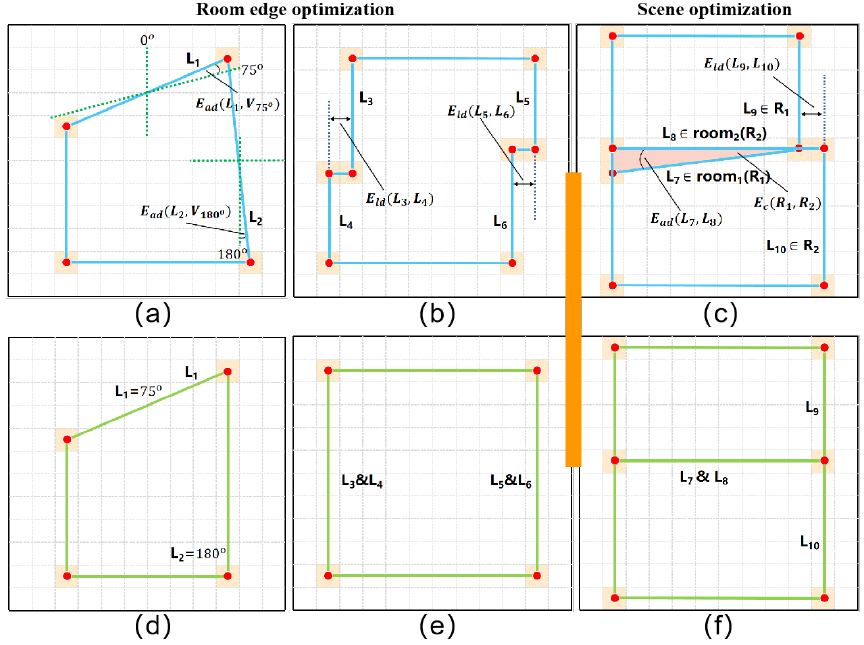
Figure 5. Illustration of the E ad , E ld , and E c terms. E ad is the angle deviation formula, E ld is the translation deviation formula, and E c is the coincidence formula. ( a ) and ( b ) indicate defects in dividual rooms, ( d ) and ( e ) correspond to the repaired situation. ( c ) and ( f ) indicate before and after overall optimization respectively.